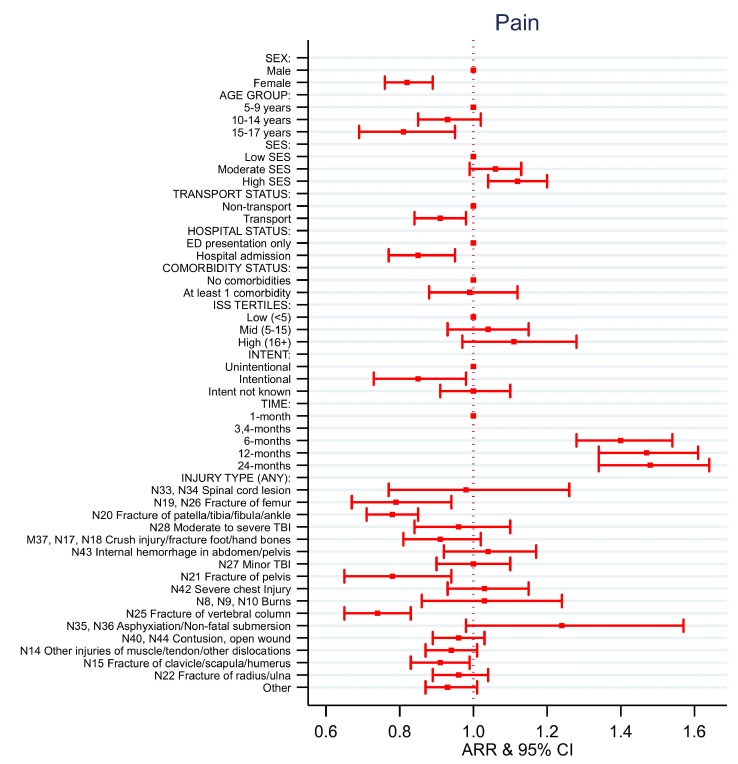
Figure 7. EQ-5D pain adjusted relative risk (ARR).